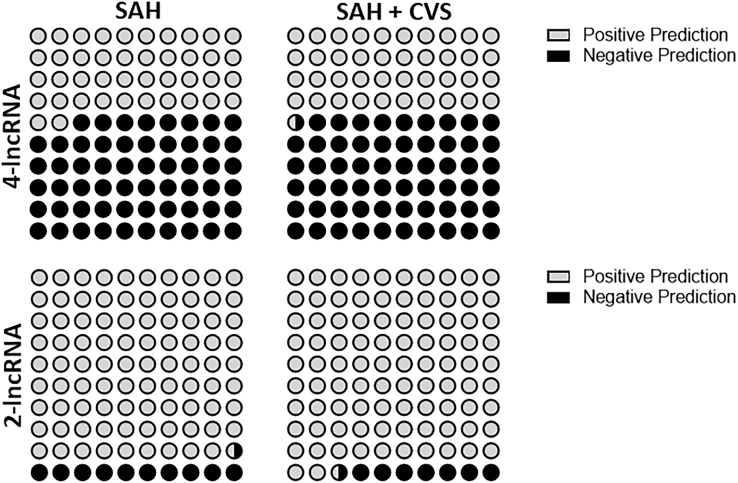
Predictive Power of lncRNA SignaturesPredictive power of a 4-lncRNA signature versus 2-lncRNA signature in predicting occurrence of CVS in patients with SAH. 4-lncRNA signature consisted of lncRNAs ZFAS, MALAT1, LINC00261, and LINC01619, whereas the 2-lncRNA signature only considered MALAT1 and LINC01619.